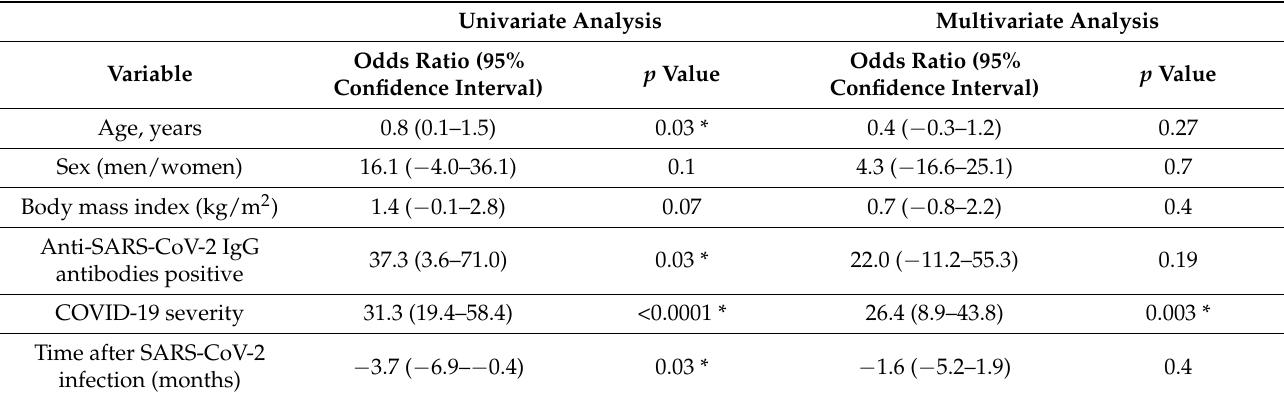
Table 4. Univariate analysis and multivariate analysis of factors associated with aggregated Spike (S) SARS-CoV-2 specific T cell response in ELISpot analysis. * significant.